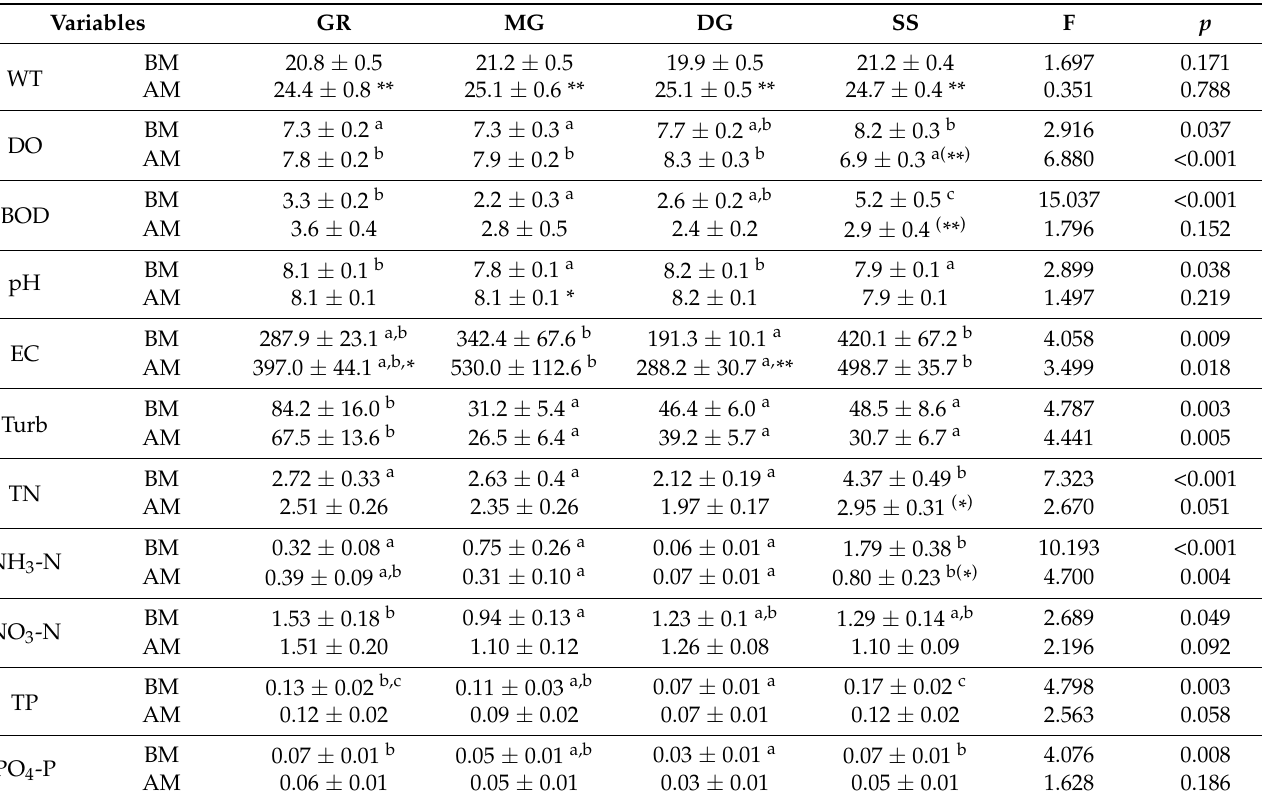
Table 3. Physical-chemical factors of the epilithic diatom communities in four central western major streams of the Korean Peninsula from 2013 to 2015 (GR: Geumgang River, MR: Mangyeonggang River, DR: Dongjingang River, SS: Sapgyocheon